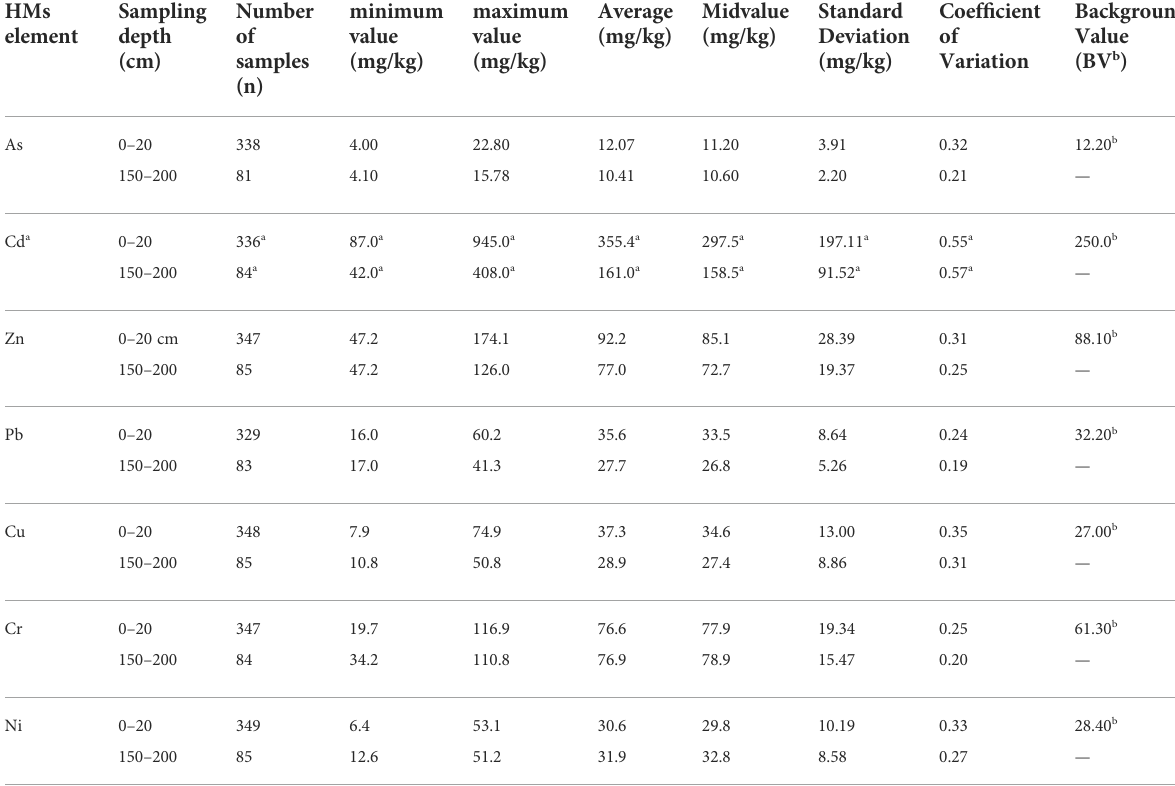
TABLE 1 The geochemical background values of heavy metal elements in soils (Jia, 2007). HMs